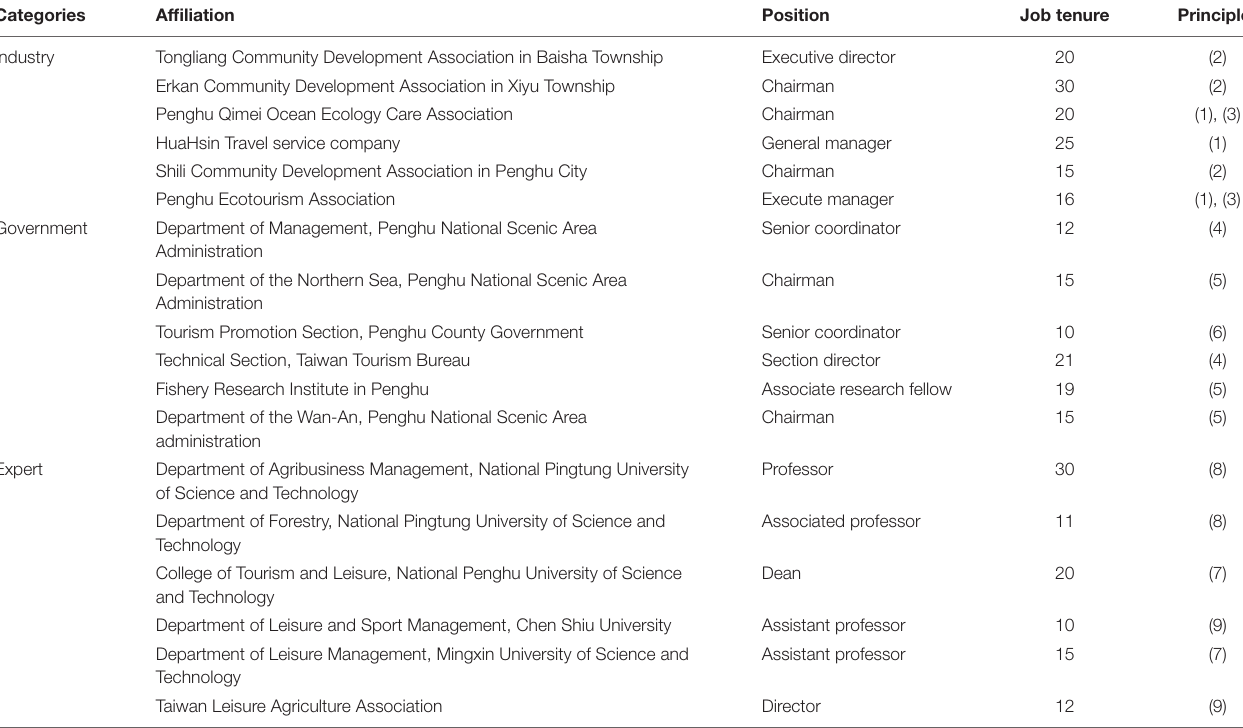
TABLE A2 | Fuzzy Delphi method members’ background for the second round.